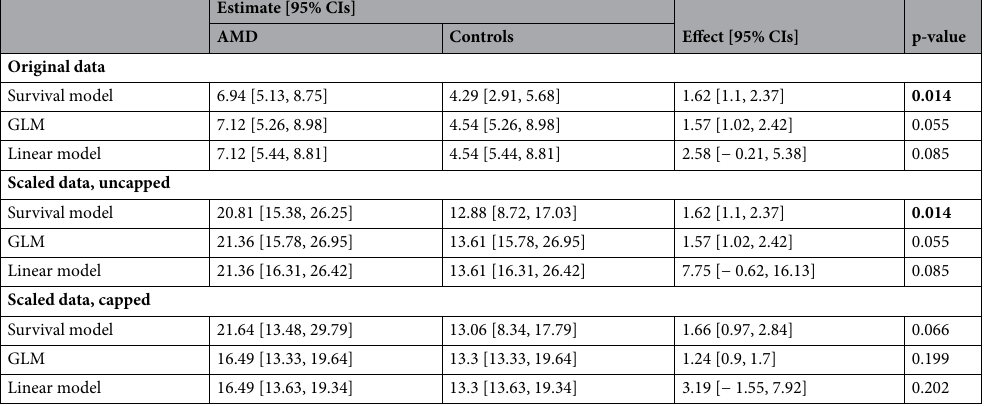
Table 2. Central estimates [95% confidence intervals (CIs)] of RIT values (in minutes) with the three methods considered (first and second columns). For the linear model (t-test) and the GLM, the mean is reported. For the survival model the estimate for the median is reported. The third column reports the effect [95% CIs] measured by the three methods, which is the basis for the calculation of the p-value. Significant p-values at an alpha level of 0.05 are shown in bold. The effect is the ratio between the mean RITs of AMD and controls for the survival model and the GLM, and the difference between the two groups for the linear model. Notice how the estimate from the survival model is much less affected by capped values.